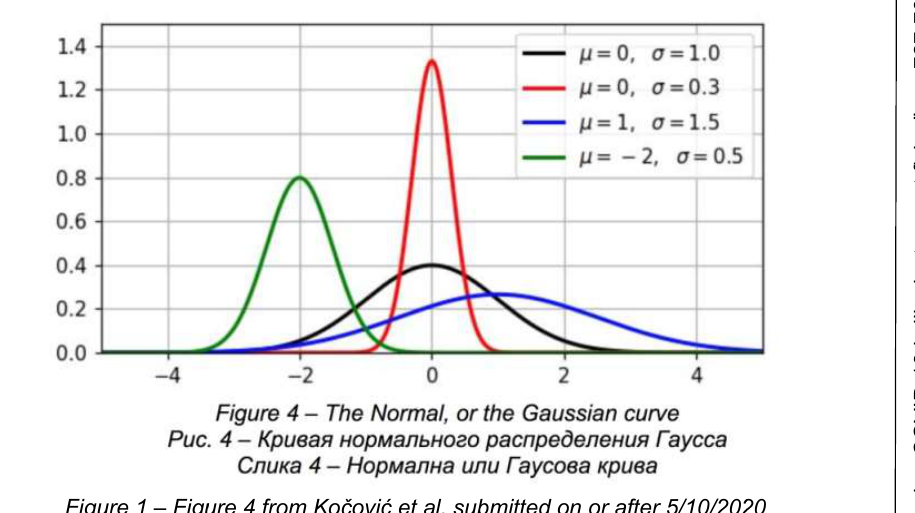
Figure 4 from Kočović et al, submitted on or after 5/10/2020